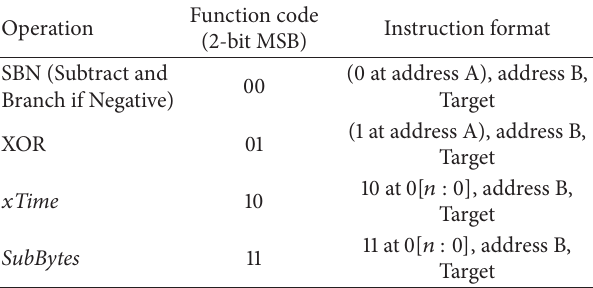
Table 4: The CISA instruction sets break